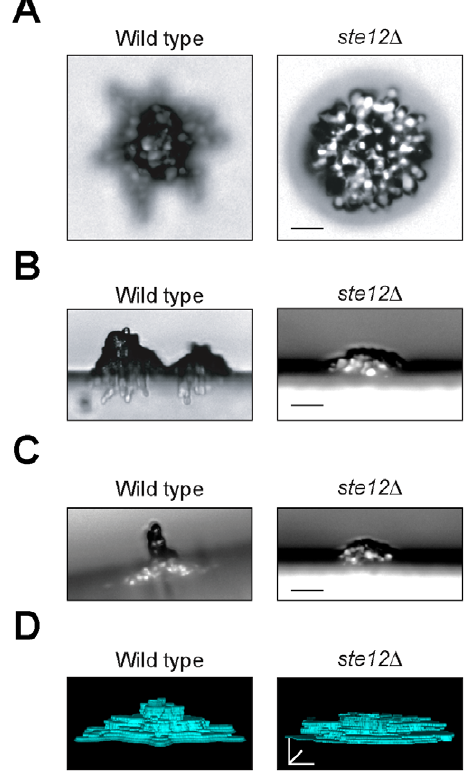
Figure 6. Analysis of filamentation in mats grown on high-agar surfaces. Wild type (PC538) and ste12 D mutant (PC539) were compared by microscopy at 10 6 on 4% agar medium. A ) Top view of typical microcolonies grown on synthetic medium lacking glucose with 4% agar, Bar, 20 microns. B ) Cross-section view of typical microcolonies as those described in panel 6A. Images were obtained by cutting the agar medium and laying agar slabs at a 90 u angle. Bar, 20 microns. C ) Plates tilted at a 20 u angle. Shown are examples of arial pseudohyphae produced by wild type microcolonies (PC538). At right, the ste12 D (PC539) mutant fails to form extensive arial pseudohyphae. The image shown is a compiled Z-stack rendering of a typical microcolony. Bar=25 microns. D) 3D rendering of the microcolonies shown in panel A. Movies of the rendered images are found in the supplemental materials (Supplemental Movies S1, S2, S3, and